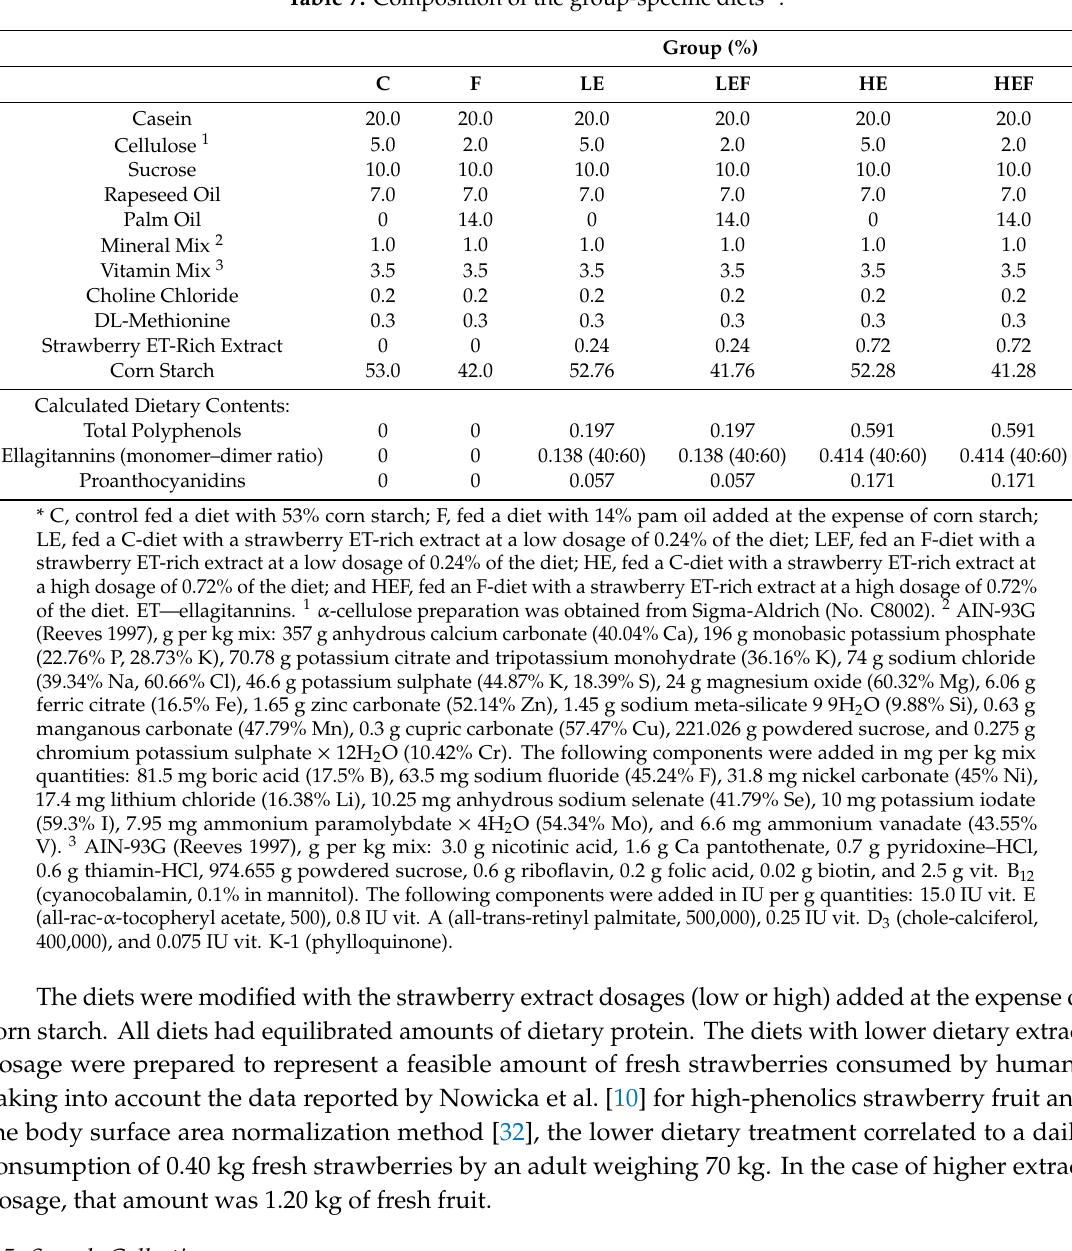
Table 7. Composition of the group-specific diets